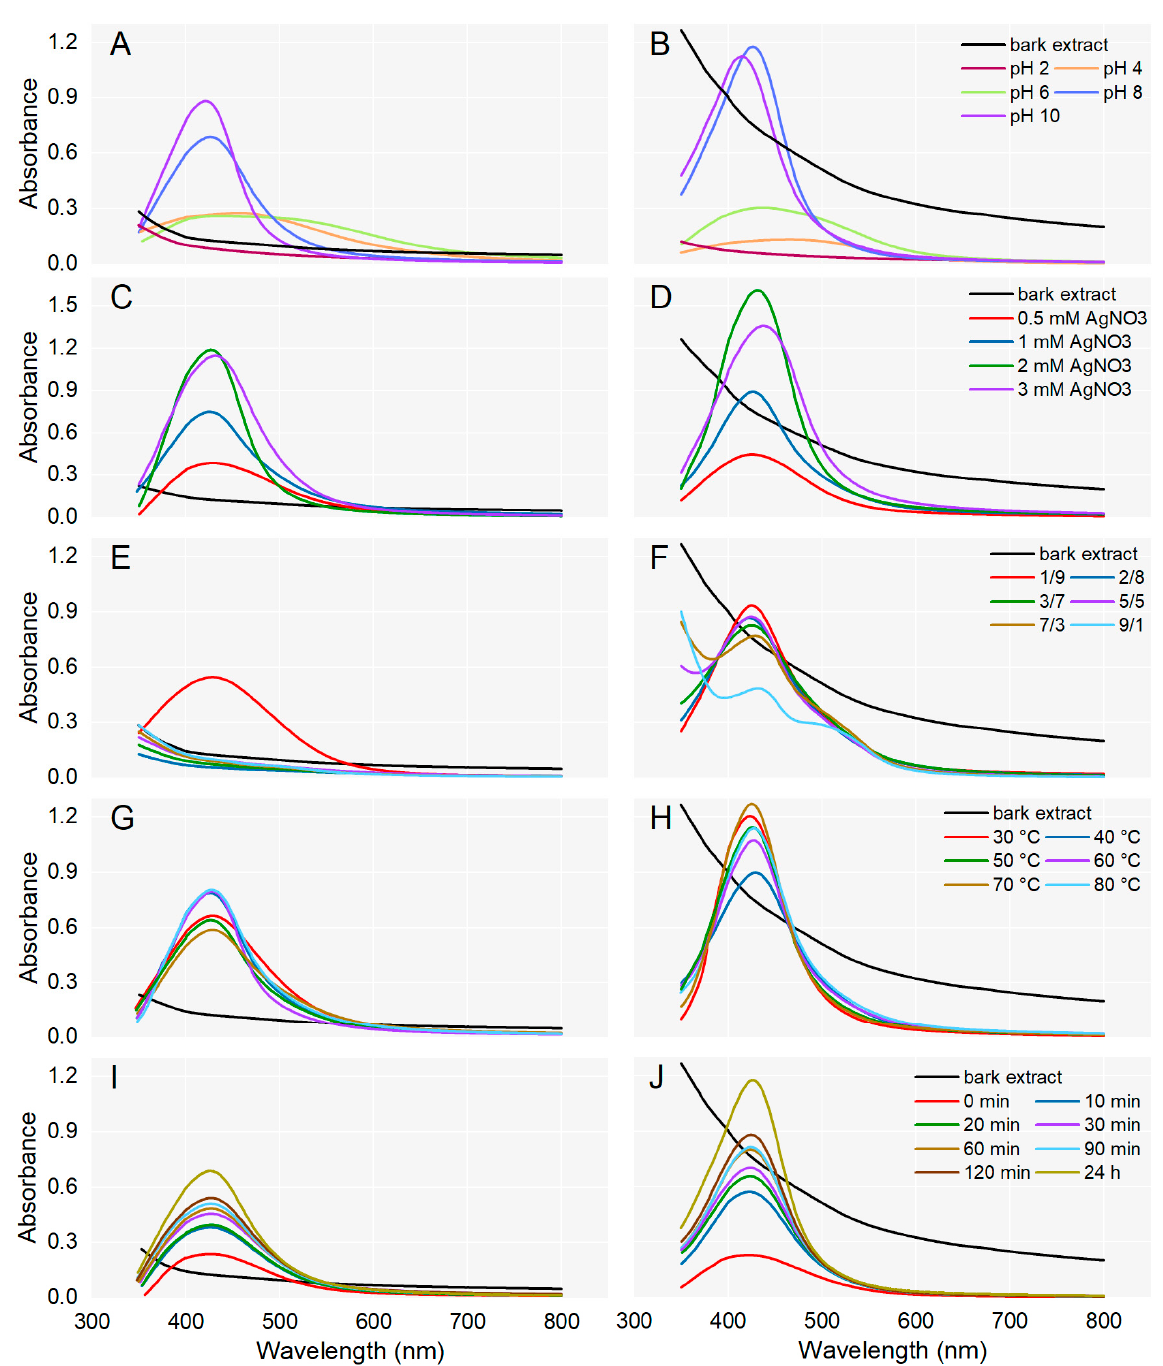
Figure 1. Effect of pH, AgNO 3 concentration, ratio between the volumes of plant extract and AgNO 3 , temperature, and reaction time on the synthesis of AgNPs from Abies alba ( A , C , E , G , I ) and Pinus sylvestris ( B , D , F , H , J ) bark aqueous